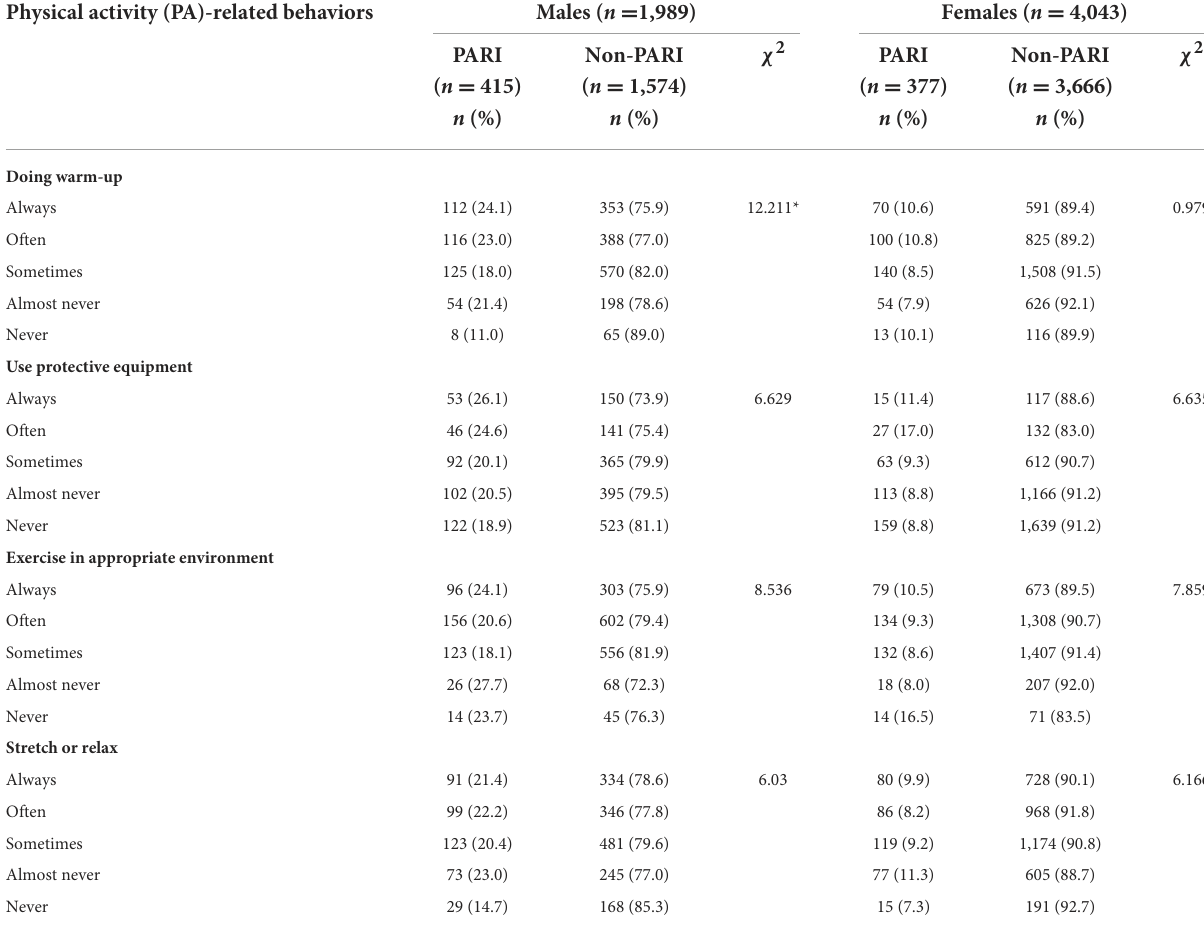
TABLE 2 Contrast of PA related behaviors for PARI and non-PARI by gender. Physical activity (PA)-related